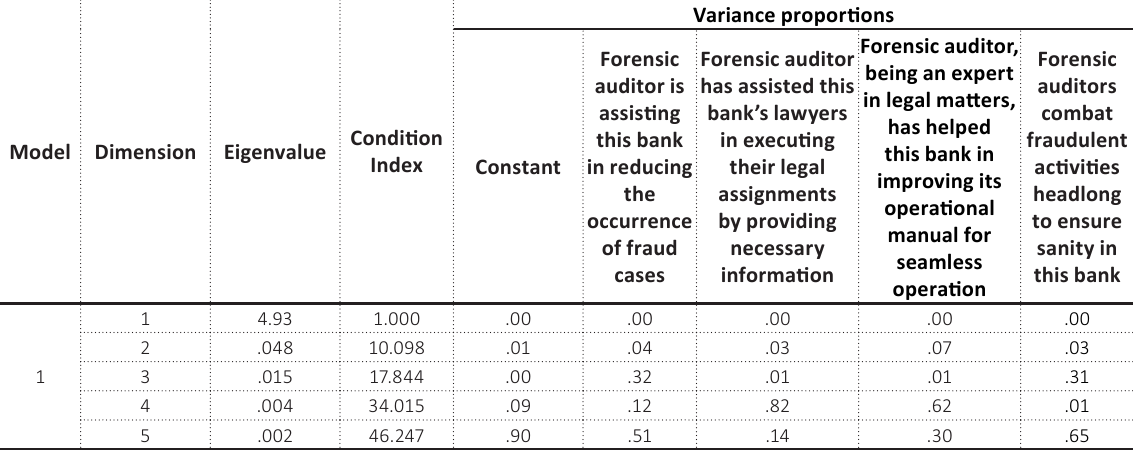
Model Dimension